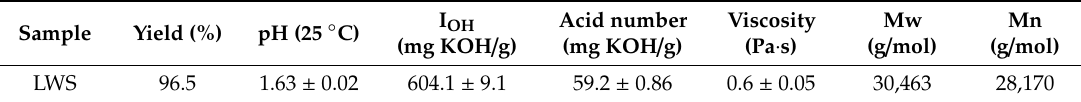
Table 2. Wheat straw polyol